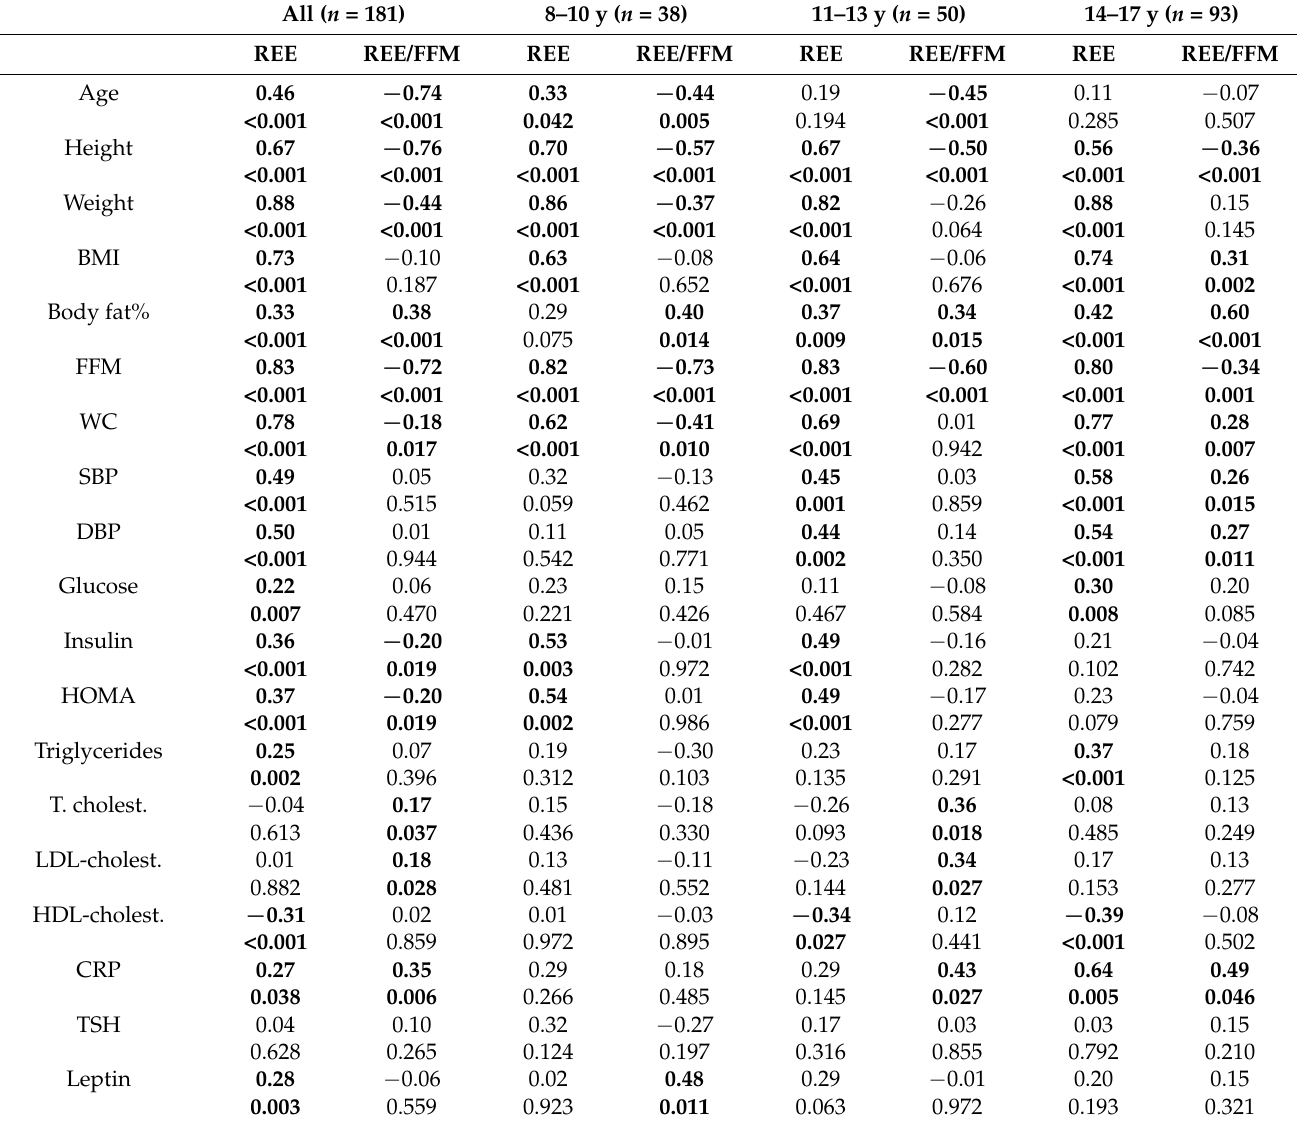
Table 2. Simple correlation analysis between REE and REE/FFM with other